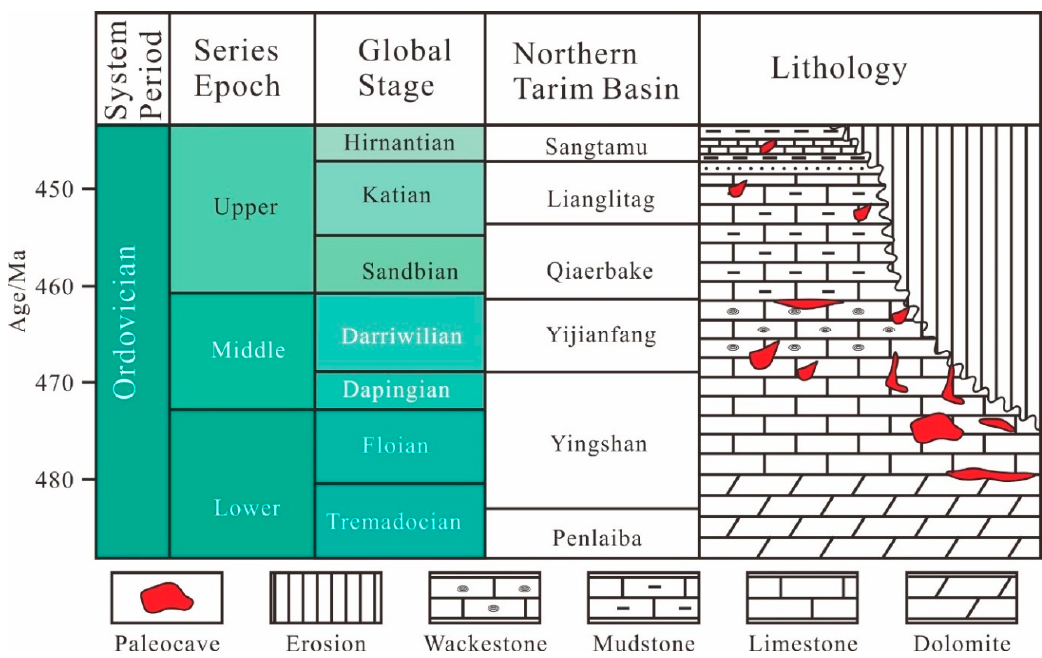
Figure 2. Chronostratigraphy and lithostratigraphy of the Tahe Oilfield, modified from Tian et al. [10,26].